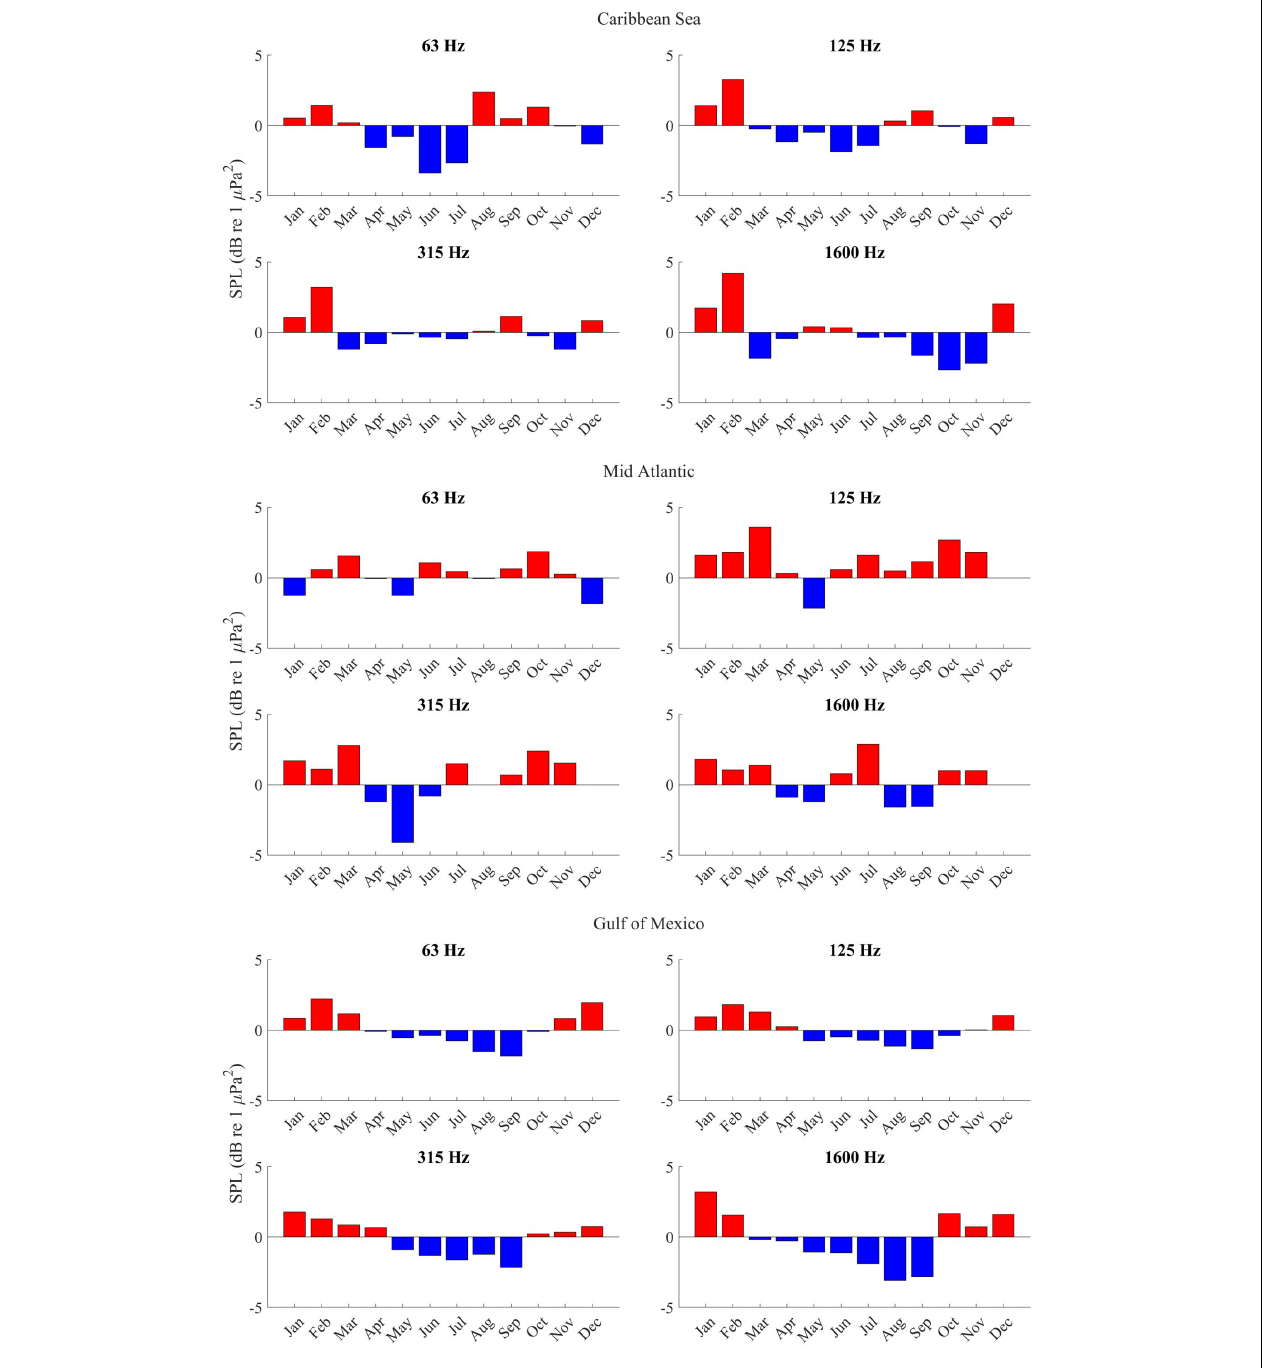
FIGURE 5 | Monthly anomalies at four decidecade bands recorded at a (top) shallow water site, Caribbean Sea; (middle) mid water site, Mid Atlantic, and (bottom) deep water site, Gulf of Mexico. Months where no bar is displayed represent 0 dB difference from the site’s overall median SPL for that decidecade band.